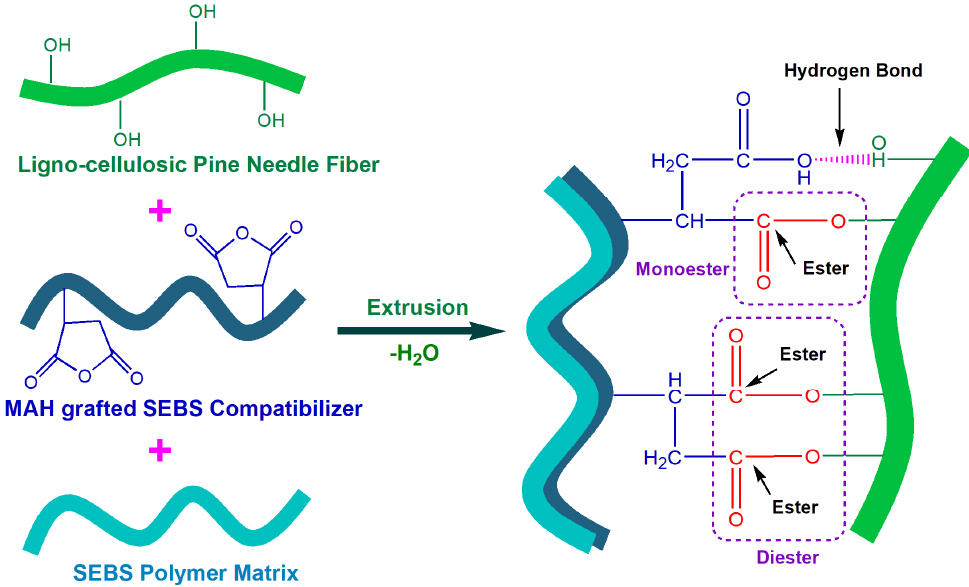
Figure 3. A possible scheme of ester formation between fiber, matrix, and compatibilizer.